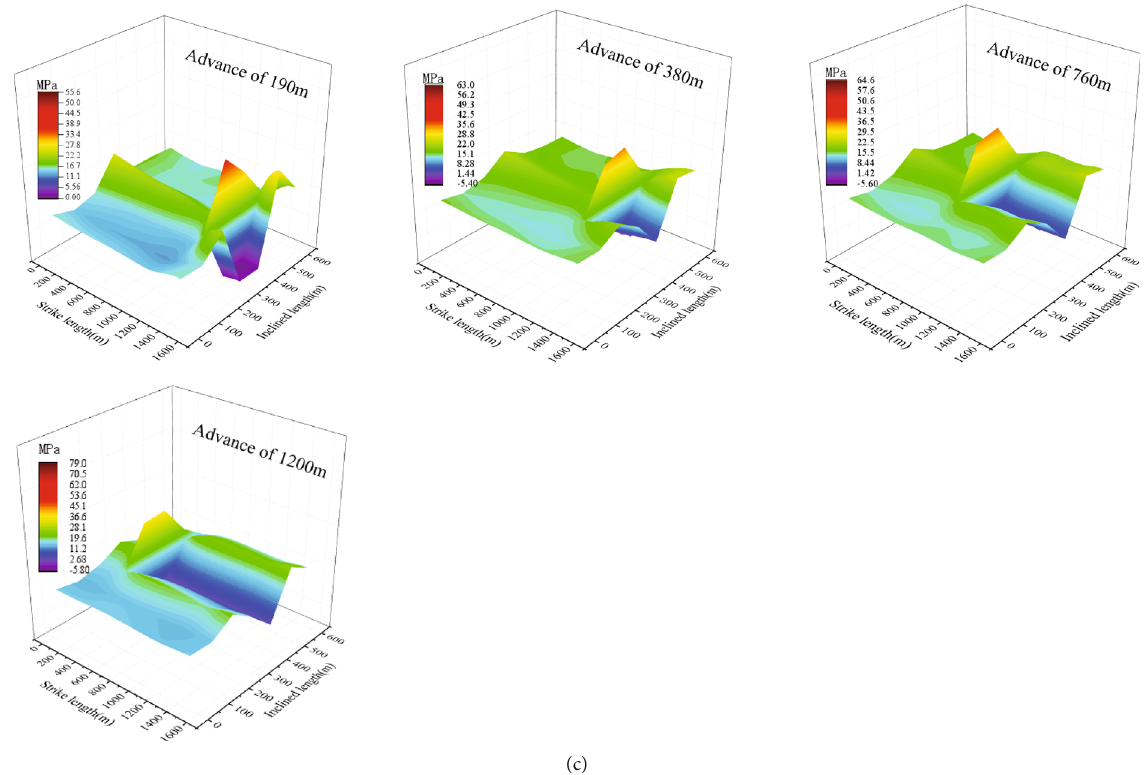
Figure 9: Vertical stress evolution for di ff erent pillar widths: (a) 5m, (b) 25m, and (c)